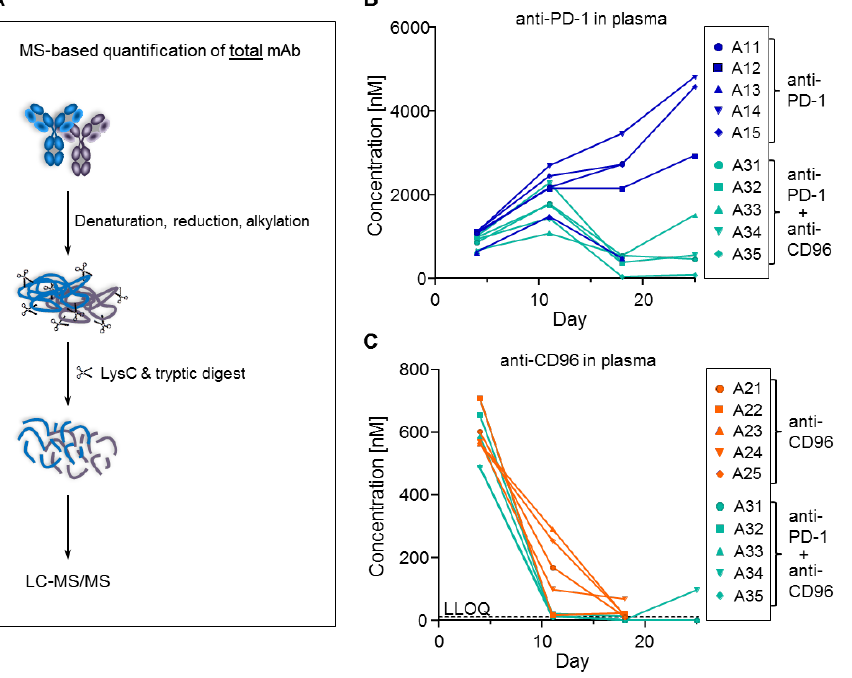
Figure 6. Total concentrations of anti-PD-1 and anti-CD96 measured by MS. ( A ) MS-based workflow for total mAb quantification. Total plasma concentrations of ( B ) anti-PD-1 and ( C ) anti-CD96 (compare with ELISA data from Figure 4). Samples below LLOQ are plotted on the x -axis. Plasma samples for animals 11, 13, 21–25 and 32 at day 25 are missing because these animals were sacrificed due to high tumor load.